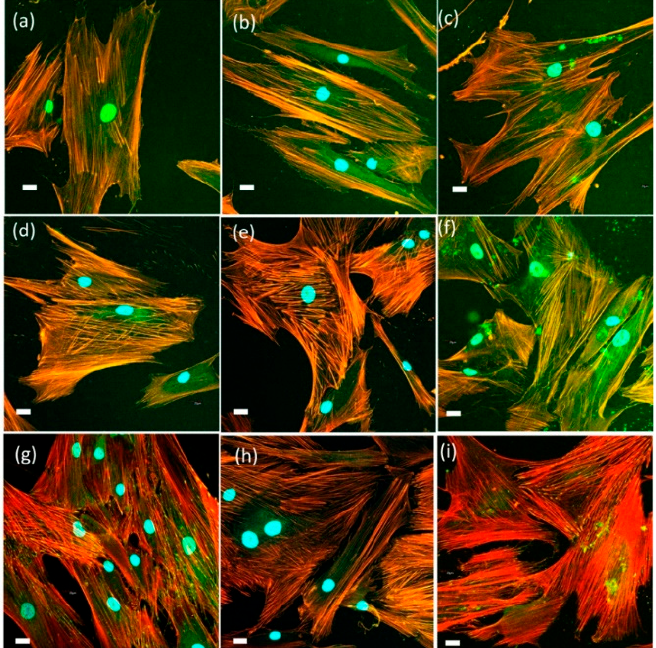
Figure 11. HOB ® human osteoblast in culture grown in the presence of xerogel SCS8_E1: ( a ) after 48 h, ( b ) after 72 h, and ( c ) after 1 week in culture. In ( d – f ) HOB ® grown in the presence of xerogel SCS8_E1 ( d ) after 48 h, ( e ) 72 h; ( f ) 1 week. In ( g – i ) control cells: after ( g ) 48 h, ( h ) 72 h; ( i ) 1 week. Images acquired in the confocal microscope after immunolabelling of actin cytoskeleton with rhodamine phalloidin (fluoresces red) and vinculin (fluoresces green) for focal adhesions. Blue, DAPI-labelled nuclei. Scale bar equals 20 μ m.